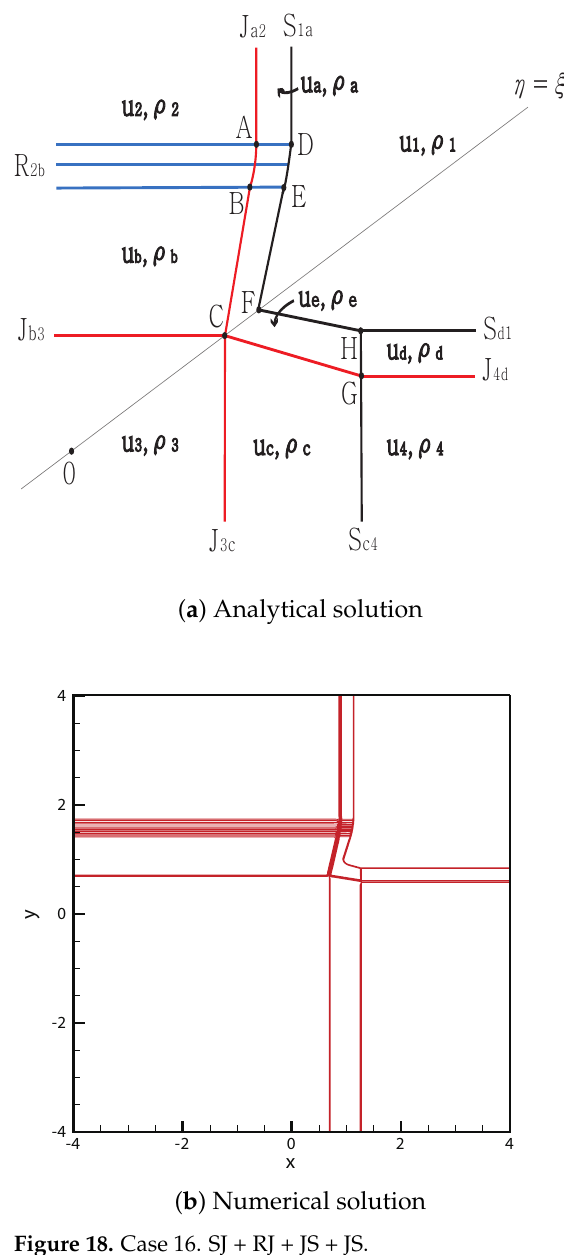
Figure 18. Case 16. SJ + RJ + JS +